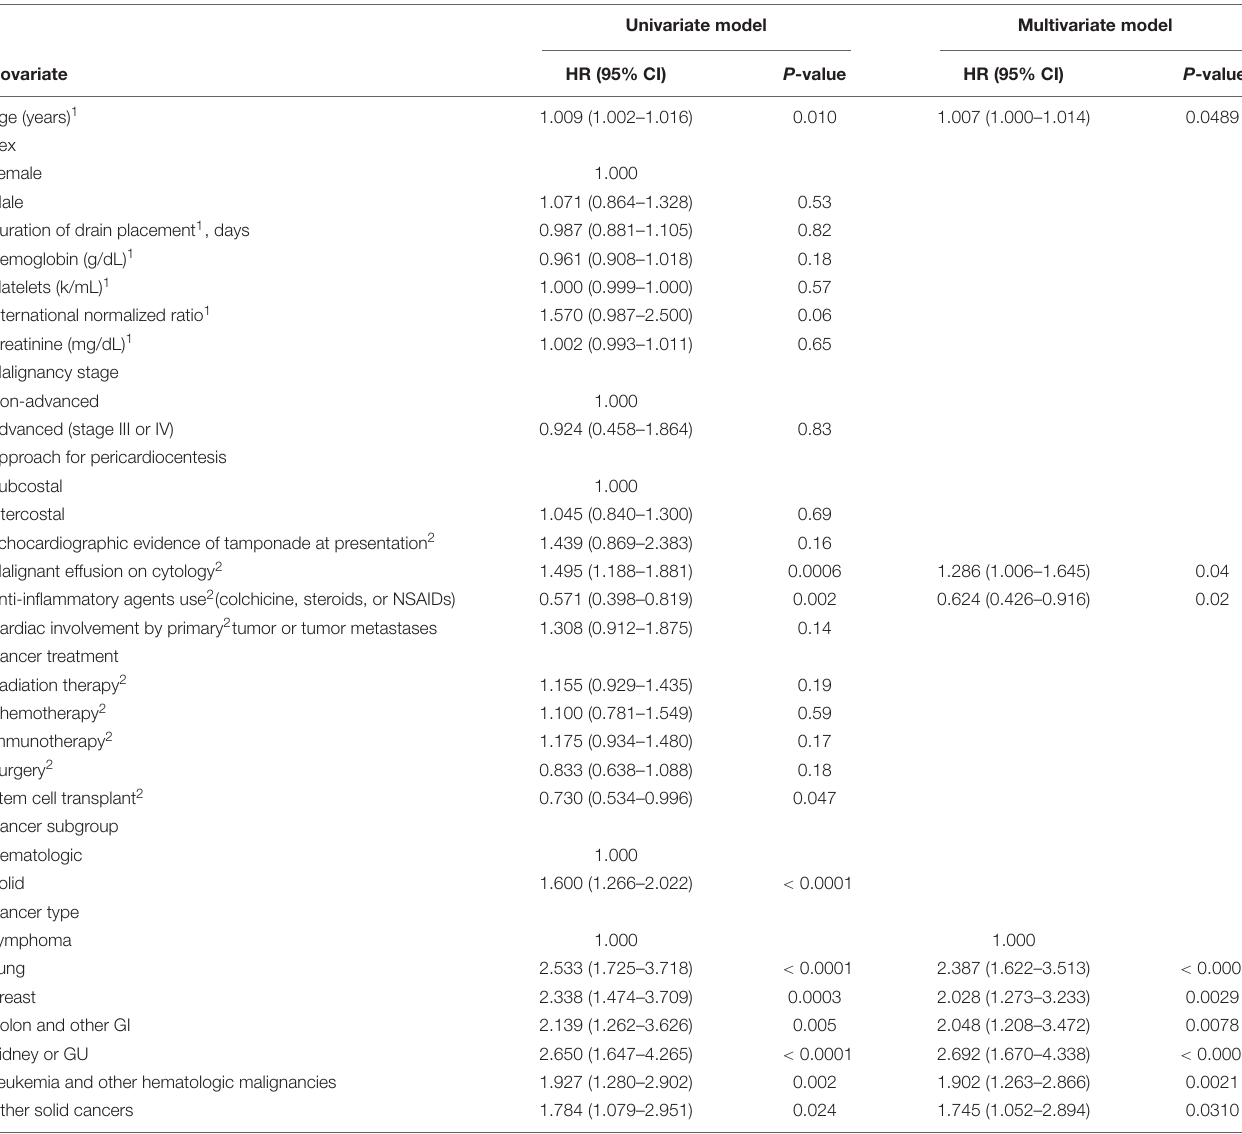
TABLE 4 | Univariate and multivariate predictors of all-cause